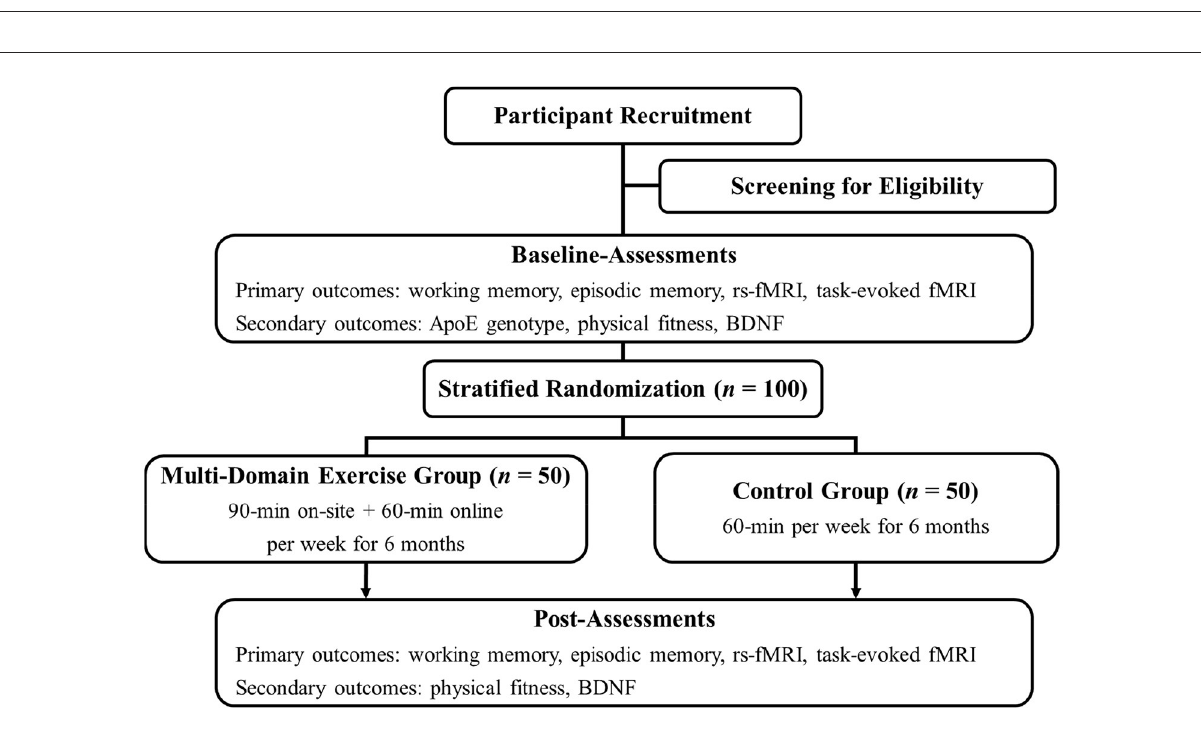
FIGURE2 Study flowchart. ApoE , apolipoprotein E; BDNF, brain-derived neurotrophic factor; fMRI, functional magnetic resonance imaging; rs-fMRI, resting-state functional magnetic resonance imaging.